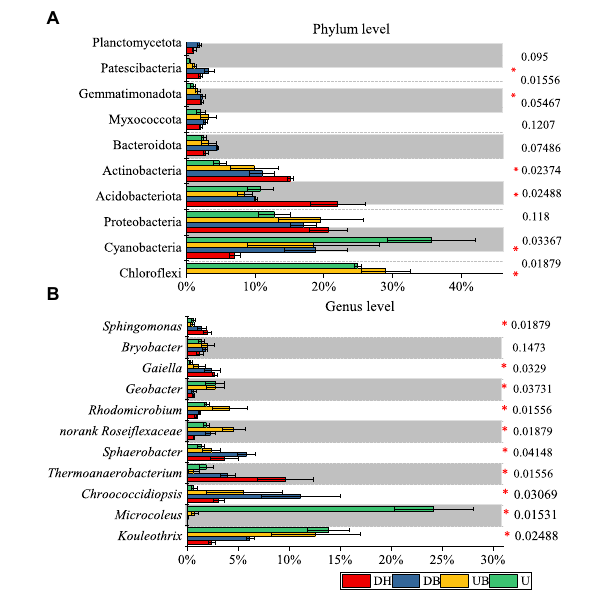
FIGURE 5 | Average relative abundance of bacteria at phylum (A) and genus (B) level ( n = 3). P -values are listed at right, * represents the significant differences at